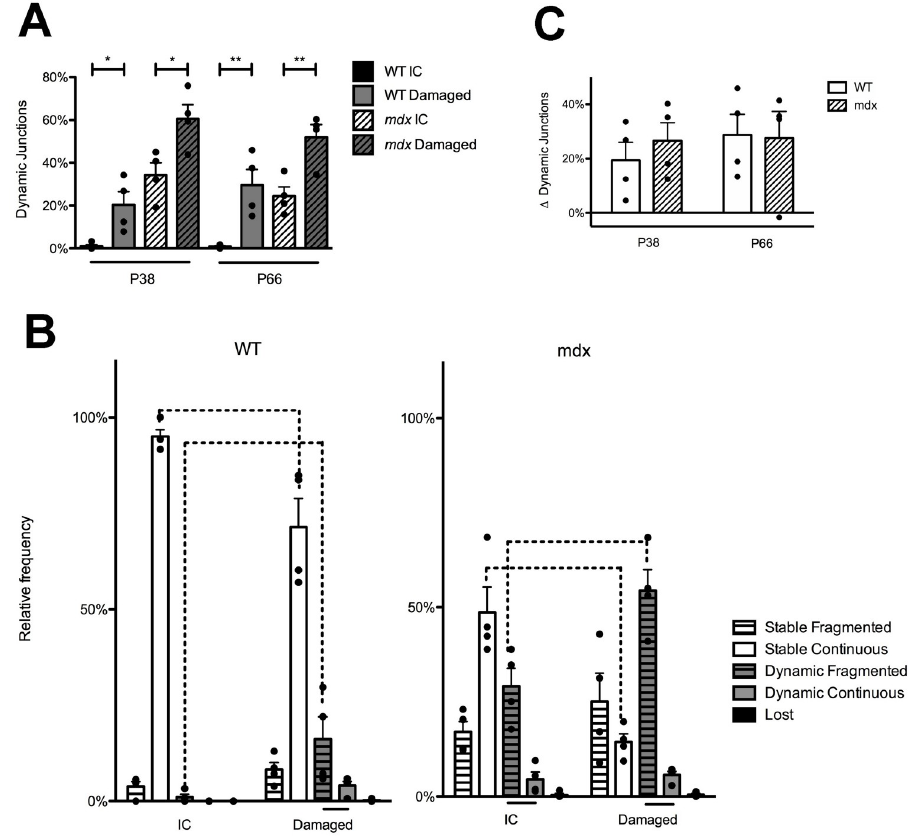
Fig 4. NMJ response to myofiber injury near the endplate in WT and mdx mice. (A) Receptor replacement following myofiber injury in WT and mdx STM. Both WT and mdx mice show increases in receptor